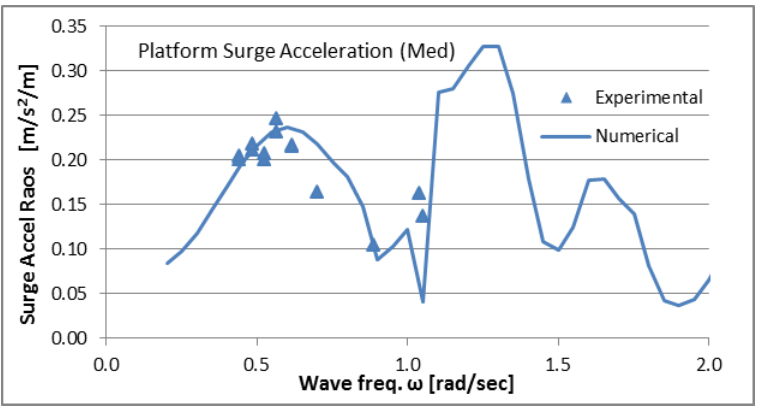
Figure 13. REFOS surge acceleration comparisons for the Mediterranean installation location.